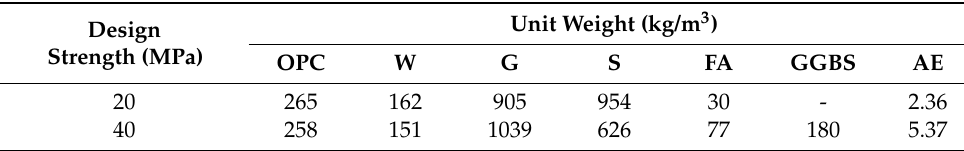
Table 1. Design strengths of concrete mixture constituents.